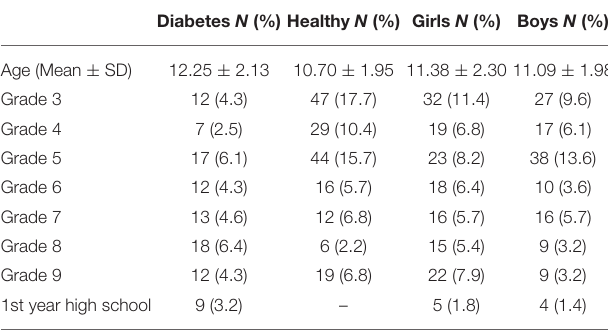
TABLE 2 | Detailed descriptive statistics on gender, grade and